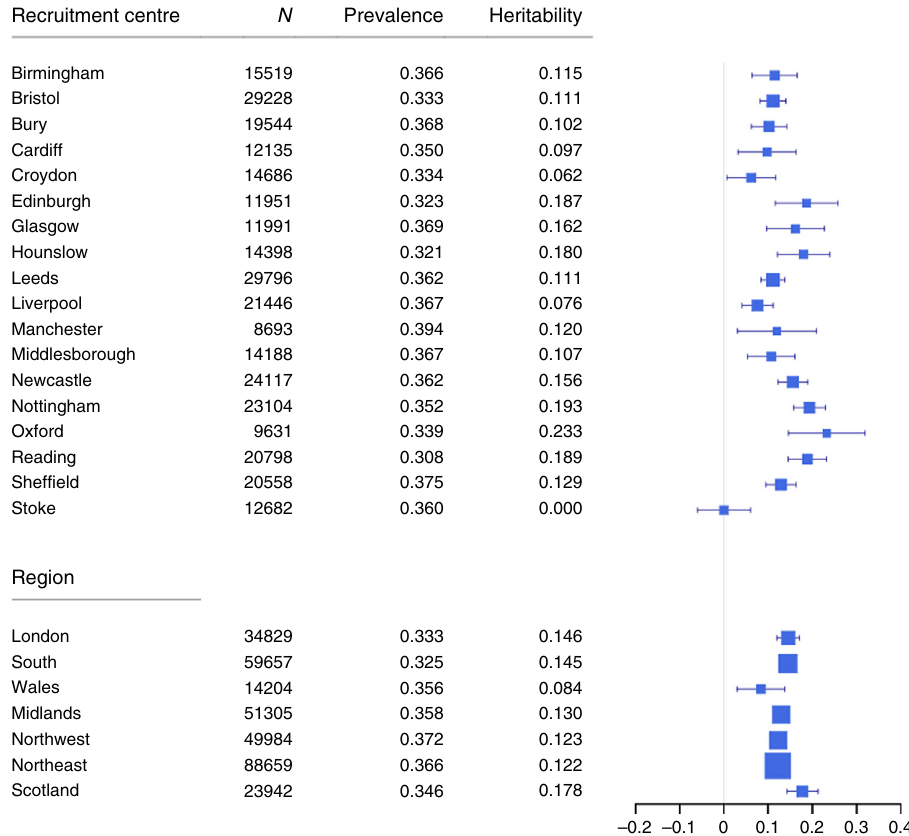
Fig. 4 Forest plot of the estimated SNP-based heritability of broad depression by recruitment centre and region. Heritabilities are provided where there was power of at least 30% to detect a heritability >0 with a trait heritability of 9%, a type I error of 0.05, a trait prevalence of 0.3527 and a variance of the SNP- derived genetic relationships of 2 × 10 −